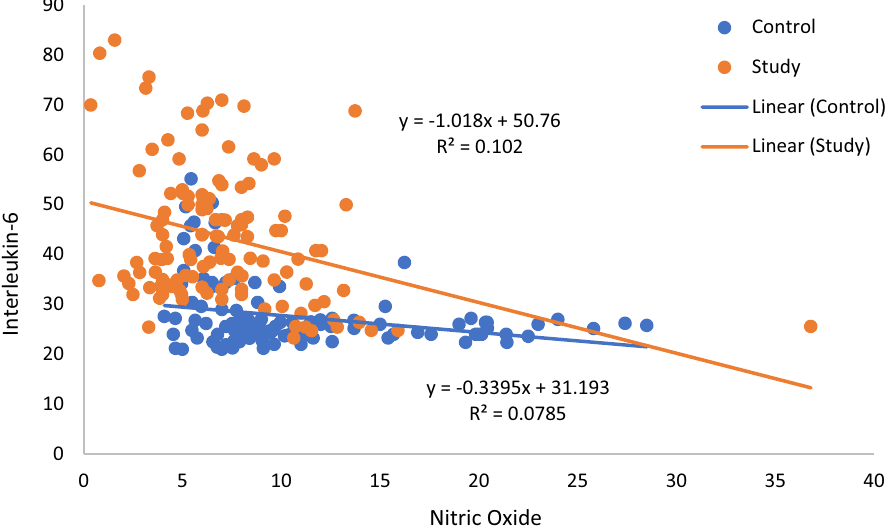
Figure 17. Pearson correlation of nitric oxide with IL-6 in control group and study group at 36th week of gestation. Blue dots represent control group and orange dots represent study group. NO is negatively correlated with IL-6 in both control and study groups and the correlation is stronger in study group ( r = − 0.319, p < 0.001).